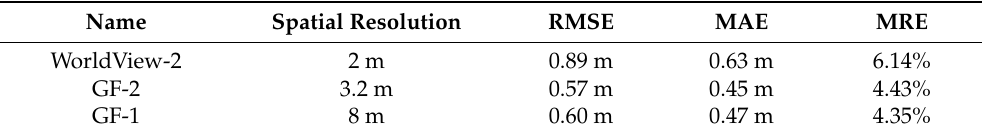
Figure 11. Results of the bathymetric signal reconstruction in the Dongdao Island study area based on three remote sensing images with different spatial resolutions: ( a ) The original data before re- construction, where the gray points represent the manually removed parts to be reconstructed. ( b – d ) The signal reconstruction results based on WorldView-2, GF-2, and GF-1 images with the in- troduction of log-ratio features, respectively. ( e – g ) The signal reconstruction results based on these three images without log-ratio features, respectively. Table 5. The accuracy of the reconstructed bathymetric signals based on remote sensing images with three different spatial